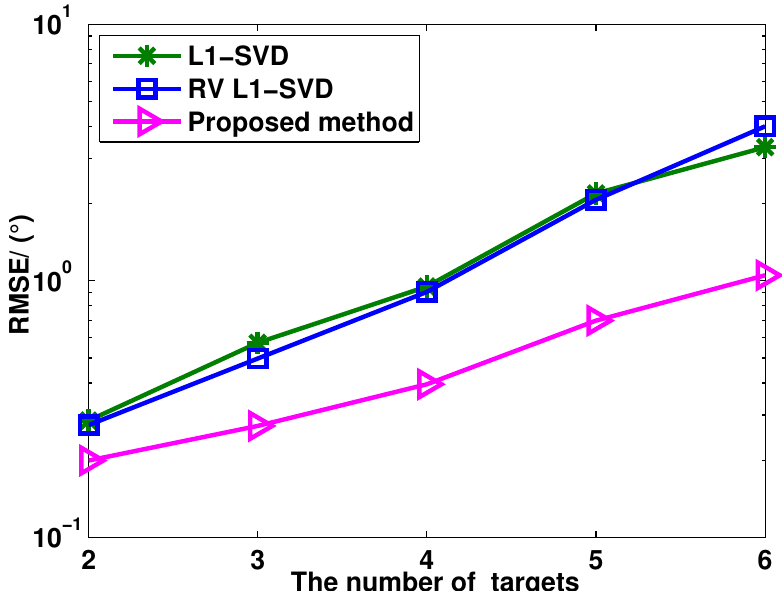
Figure 6. RMSE of l of